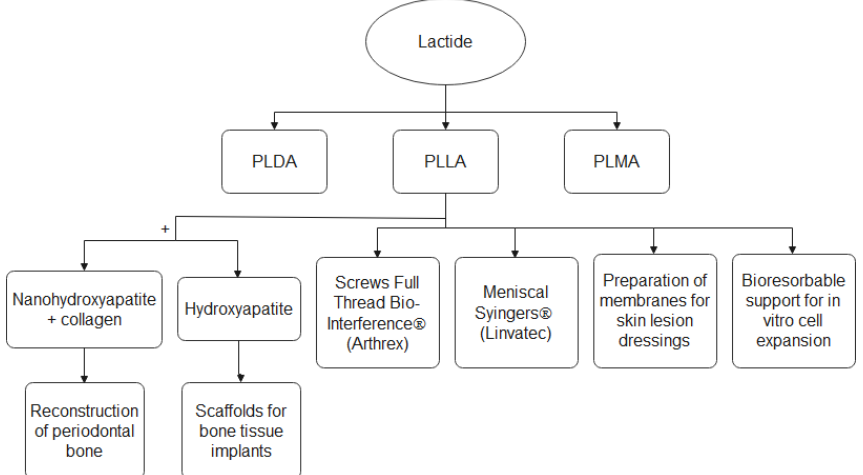
Figure 11. Application of PLA in medicine.